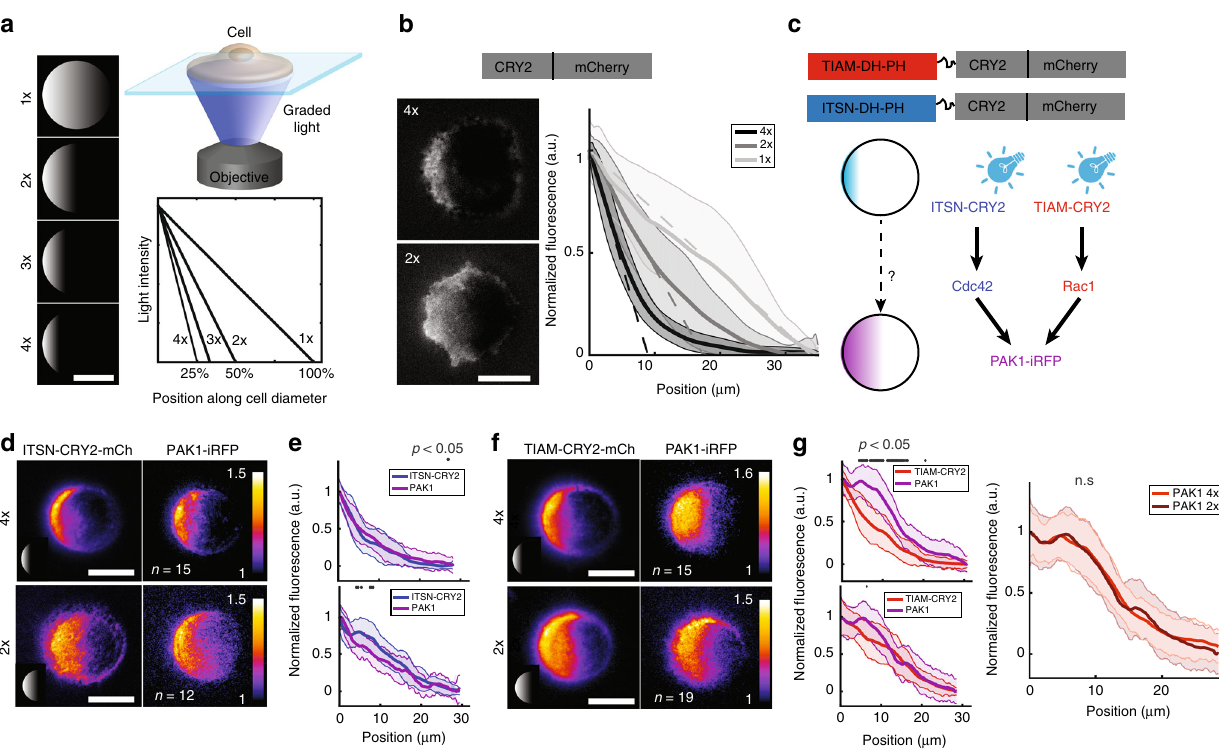
Fig. 2 Cdc42 and Rac1 have different responses to GEF activation. a We imposed GEF activity gradients of different slopes using optogenetics. Patterned illumination with grayscale levels (left) was shone onto the samples, imposing linear light gradients of the same amplitude but different spatial extents on cells attached on round micropatterns of 35 µ m in diameter (top right). The reference gradient called 1× spans over the whole diameter of the cell. The gradient 2× spans over a half cell diameter, and therefore has a slope twice as sharp as for the gradient 1× (bottom right). b Membrane recruitment of the optogenetic partner CRY2-mCherry to the basal side of cells on round micro-patterns following 30 min of illumination with 4× (top left) and 2× (bottom left) gradients. mCherry fl uorescence (solid lines) was measured along the cell diameter following illumination with 1× (light gray), 2× (medium gray) and 4× (black) gradients (dashed lines). Error bars indicate the s.d. of n = 15 (1×), n = 24 (2×) and n = 15 (4×) cells. c We activated GEFs of Cdc42 (ITSN) or Rac1 (TIAM) with light gradients and measured the fl uorescence pattern of PAK1-iRFP. Schemes at the top represent the fusion proteins used. d PAK1-iRFP recruitment following 4x (top) or 2× (bottom) activation gradients of ITSN. Fluorescence was recorded using TIRFM in HeLa cells on round micro-patterns, and initial fl uorescence was subtracted for normalization. Micrographs represent the averaged fl uorescence of n = 15 (4×, top) or n = 12 (2×, bottom) cells. Insets show the illumination patterns (not to scale). e Normalized fl uorescence of ITSN-CRY2-mCherry (blue) and PAK1-iRFP (purple) was measured along the cell diameter and averaged (solid lines). Error bars: s.d. Gray lines at the top show positions at which the curves are statistically different ( p < 0.05, Wilcoxon ’ s rank sum test). f PAK1-iRFP recruitment following 4× (top, n = 15) or 2× (bottom, n = 19) activation gradients of TIAM. g Normalized fl uorescence of TIAM-CRY2-mCherry (red) and PAK1-iRFP (purple) along the cell diameter of n = 15 (4×, top) or n = 19 (2×, bottom) cells, Error bars: s.d. Gray: Wilcoxon ’ s rank sum test ( p < 0.05). Single cell data for e and g are presented in Supplementary Figure 3. Scale bars: 20 µ